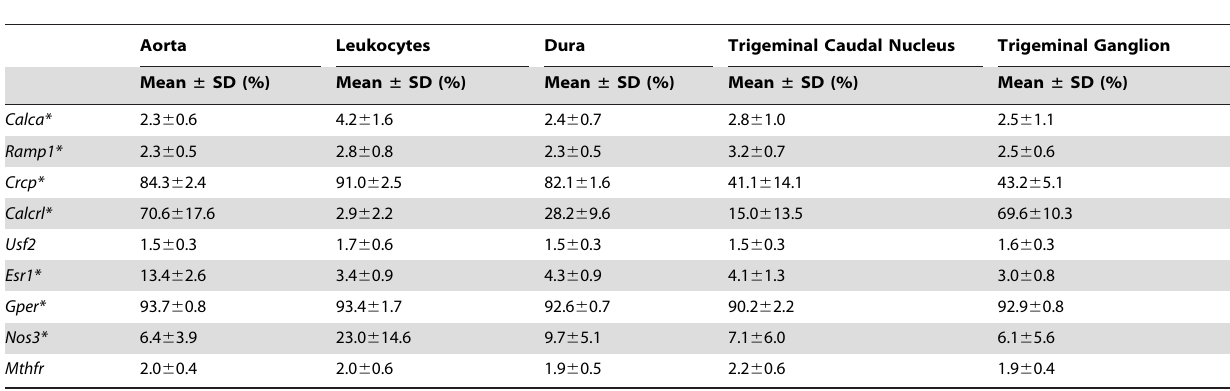
Table 2. Mean methylation of CpG islands of candidate genes in aorta, leukocytes, dura mater, trigeminal caudal nucleus and trigeminal ganglion.